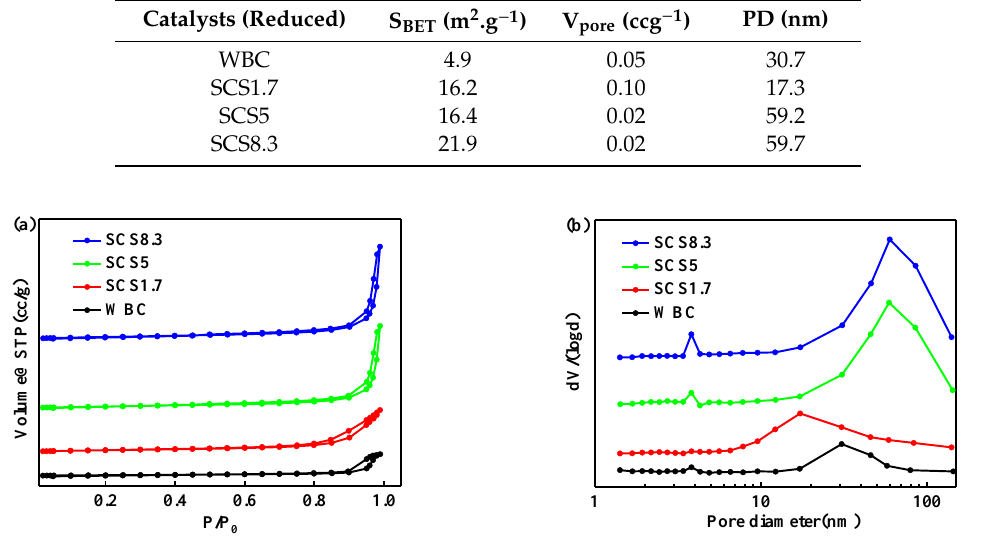
Figure 2. N 2 physical adsorption results for (SCS) and WBC catalyst. ( a ) The isotherms of N 2 adsorption-desorption and ( b ) BJH pore size distribution curves.